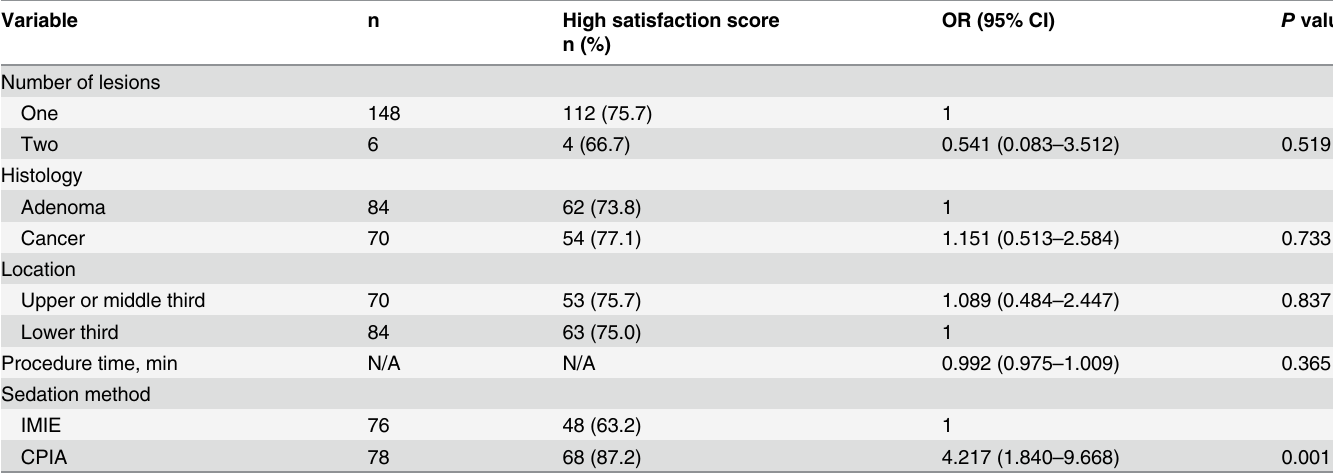
Table 5. Associate factor for affecting high satisfaction score of